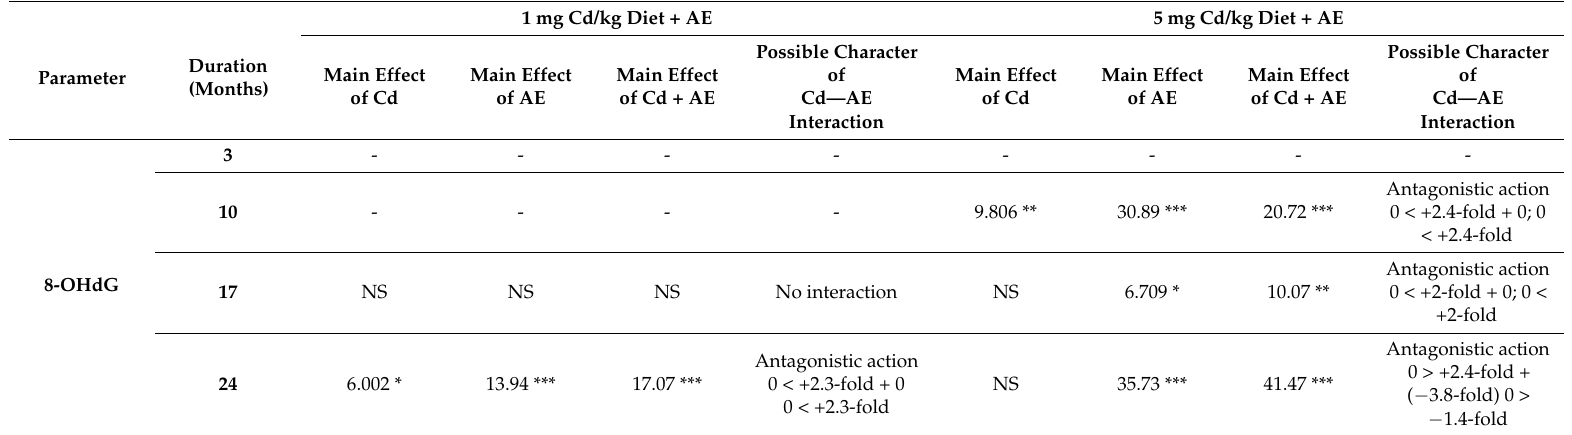
Table 3. Main and interactive effects of cadmium (Cd) and the extract from Aronia melanocarpa L. berries (AE) on the concentration of 8-hydroxy-2 (cid:48) -deoxyguanosine (8-OHdG) in the liver of female rats. 1,